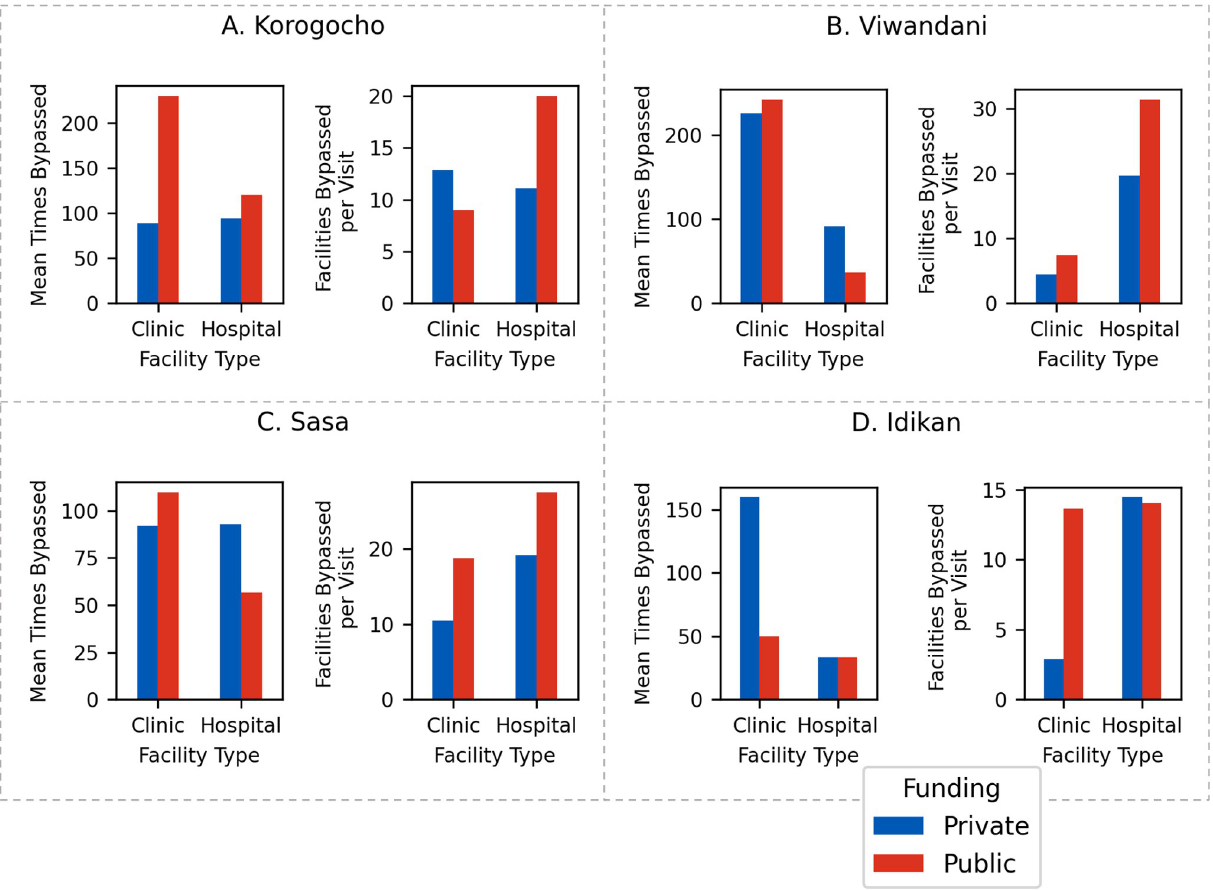
Fig 6. Bar charts demonstrating bypass behaviour in each slum, showing the mean number of times each HCP class is bypassed, and per visit how many other HCPs are bypassed by HCP class.